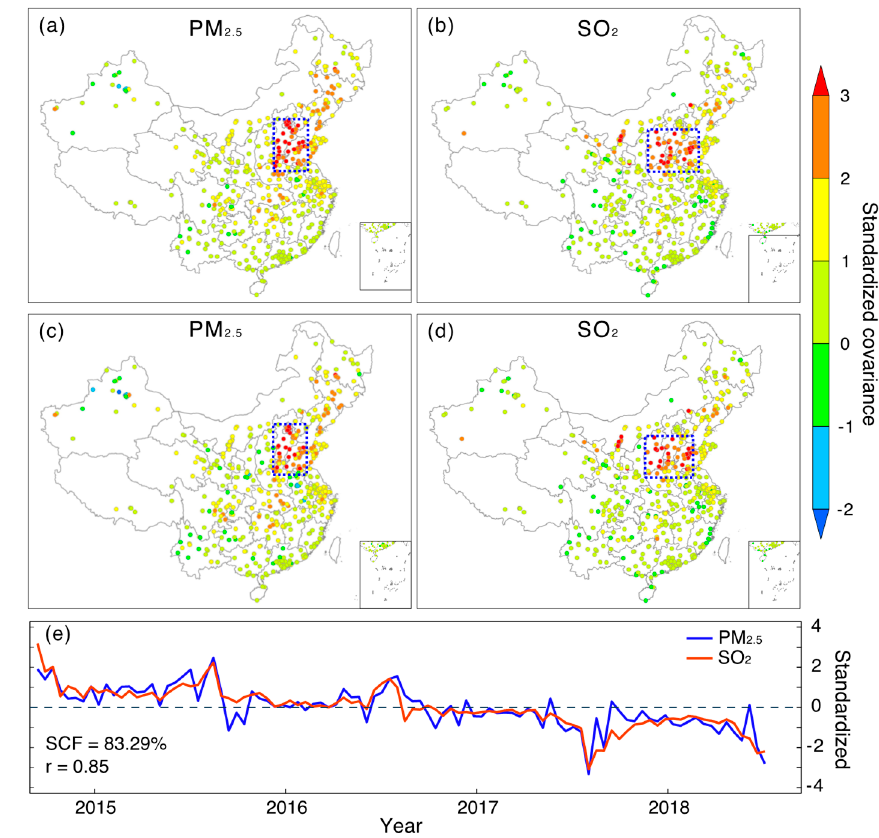
Figure 4. The first MCA mode between PM 2.5 and SO 2 coupled in the spatial and temporal domains. ( a–b ) Homogeneous covariance maps (covariance between expansion coefficient and time series of the same original field); ( c–d ) heterogeneous covariance maps (covariance between expansion coefficient and time series of another field); ( e ) standardized expansion coefficient (divided by their standard deviations) of the first MCA mode. Note that the annual cycle has been removed from each field prior to MCA analysis.